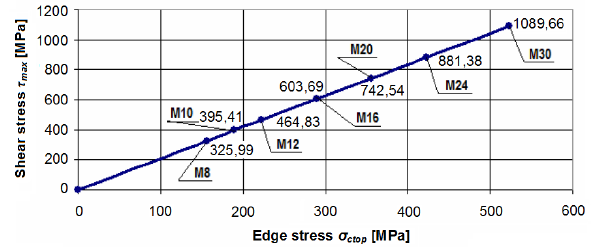
Figure 10: Dependency shear stress – edge stress for M8 ÷ M30 anchors in a balcony slab.